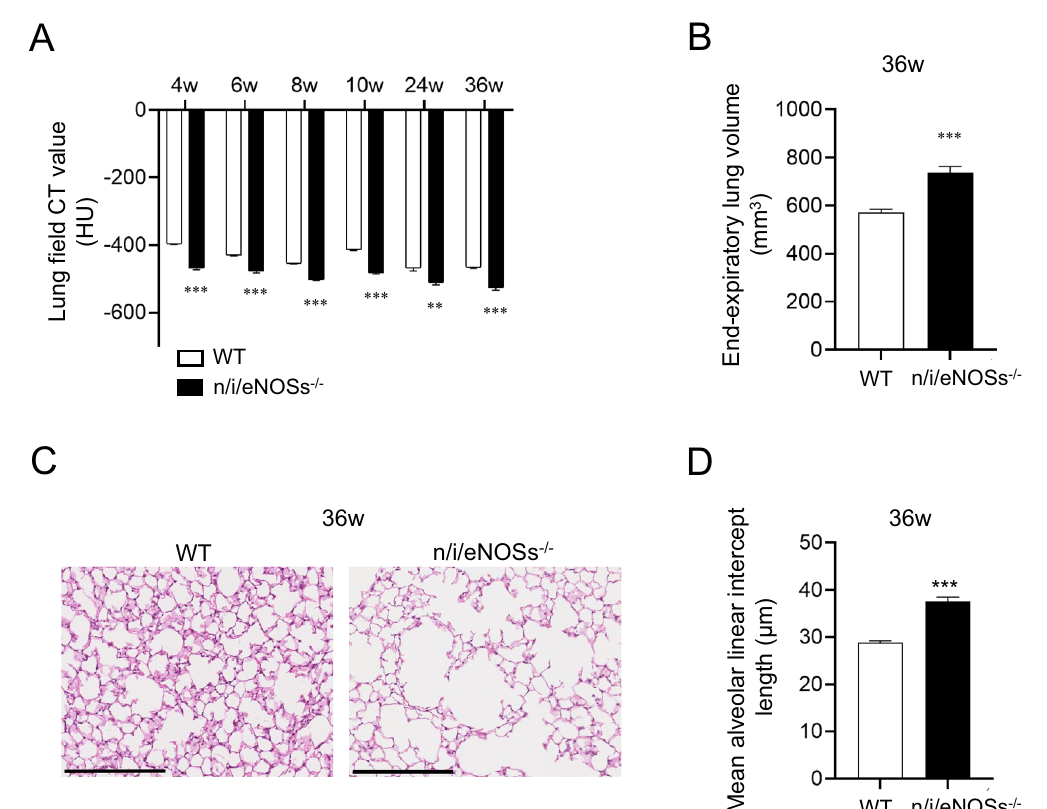
Figure 3. Progression of spontaneous pulmonary emphysema in triple n/i/eNOSs −/− mice. (A) Time course of CT value in the lung field in WT and triple n/i/eNOSs −/− mice from 4 to 36 weeks after birth (n = 6–10). ** P < 0.01, *** P < 0.001 between WT and triple n/i/eNOSs −/− mice at each time point. (B) End-expiratory lung volume at 36 weeks after birth. *** P < 0.001. (C) Hematoxylin and eosin staining of lung tissues in WT and triple n/i/eNOSs −/− mice at 36 weeks after birth. Scale bar = 250 μm. (D) The mean alveolar linear intercept length in WT and triple n/i/eNOSs −/− mice at 36 weeks after birth. *** P < 0.001 vs. WT mice.